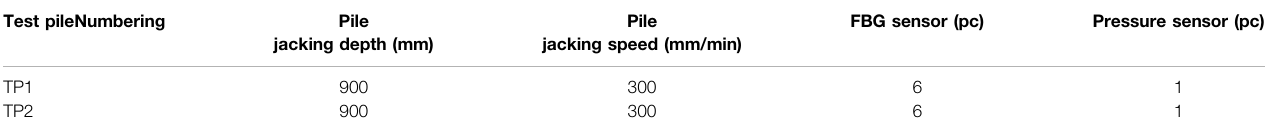
TABLE 5 | Test pile test plan table. Test pileNumbering